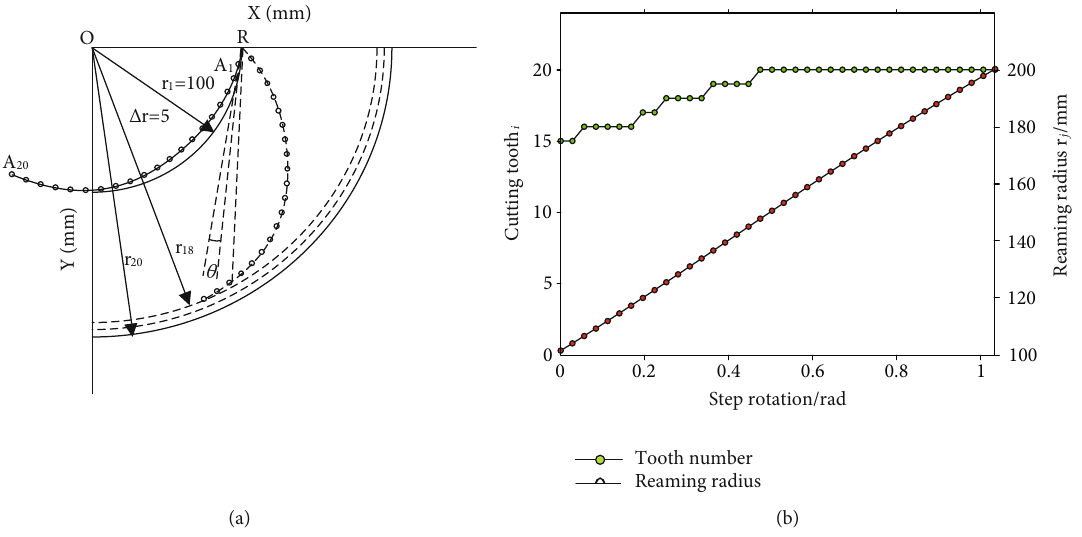
Figure 2: Curve of the horn shape blade. (a) Horn shape blade curve. (b) Reaming radius and related